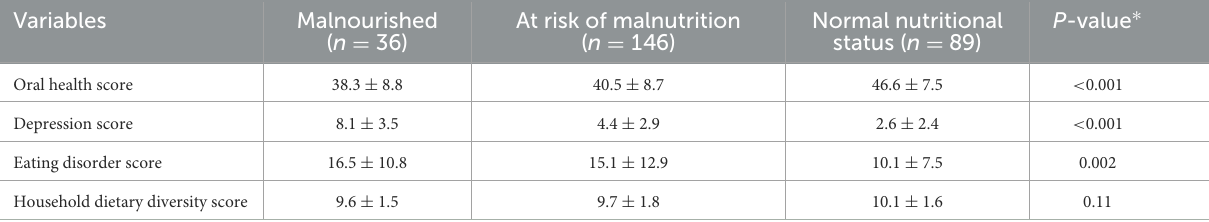
TABLE 3 Association between nutritional status of older people and other health conditions.